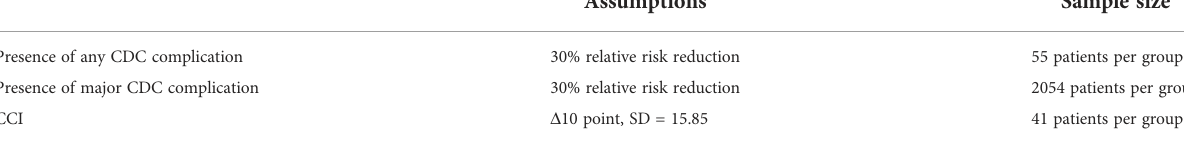
TABLE 3 Sample size calculation for surgical RCTs using different measurements.